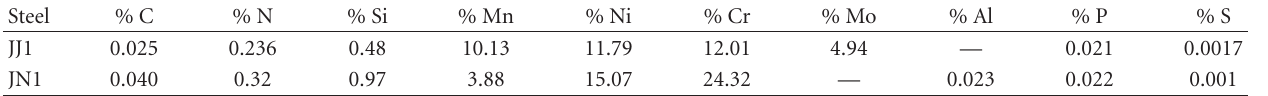
Table 1: Chemical composition of JJ and JN